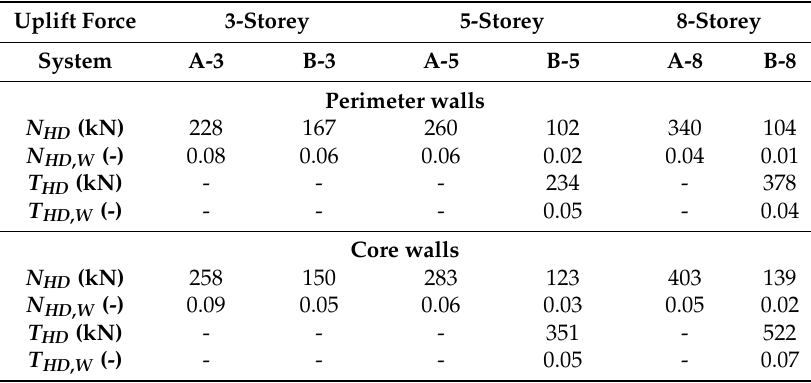
Table 5. Uplift forces at